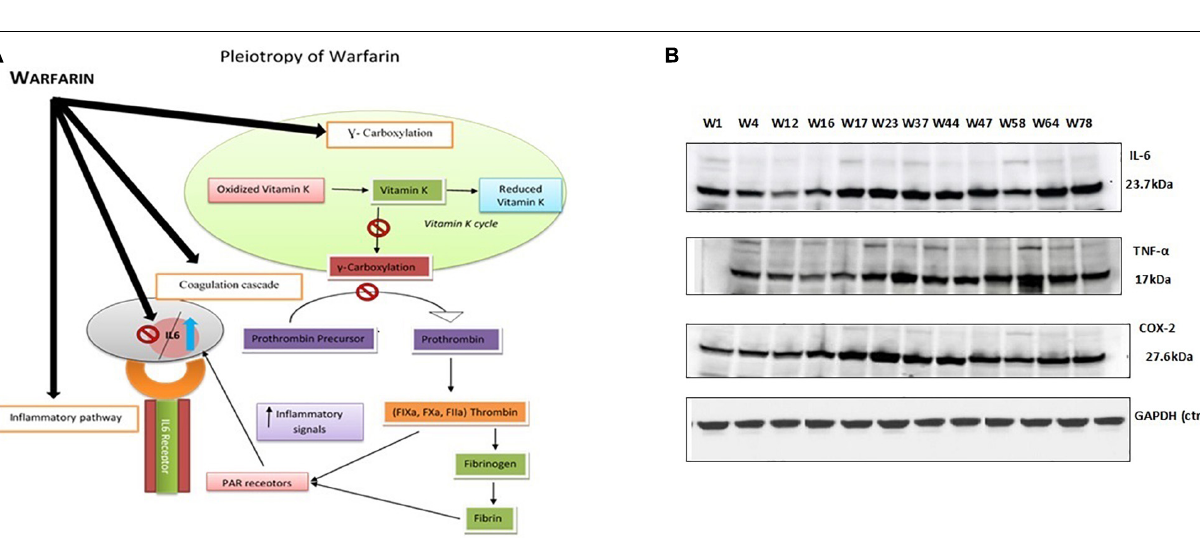
FIGURE 7 | (A) Proposed model of warfarin’s pleiotropic effect: Illustrates that warfarin either in a low dose or a high dose inhibits the effect of the vitamin K cycle and thus gamma carboxylation in a controlled manner. Therefore, prolonging the coagulation pathway. The process of gamma carboxylation and inflammatory pathway goes side by side; thus, warfarin if affecting the coagulation pathway also influences the inflammatory pathway by directly inhibiting or stimulating the interacting cytokine levels. (B) Western blot protein expression analysis: IL-6 (23 kDa), TNF- α (17 kDa), and COX-2 (27 kDa) protein expression levels with a higher dose ( > 10 mg/day) of warfarin drug along with endogenous control GAPDH (37